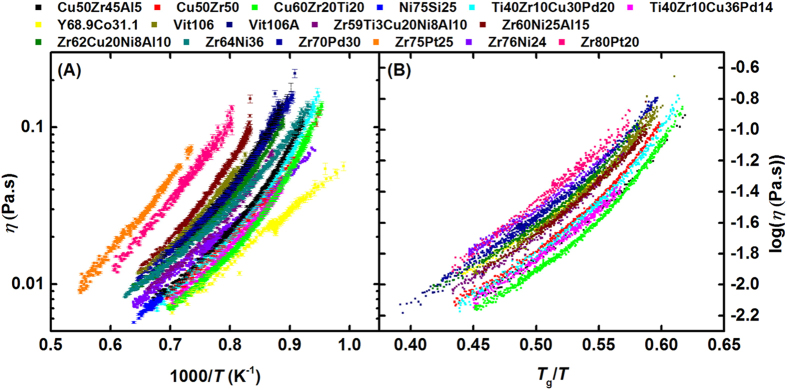
(A) Measured viscosity, η, as a function of temperature for metallic liquids. Error bars are one s.d. (B) An Angell plot of the log(η) as a function of Tg/T.